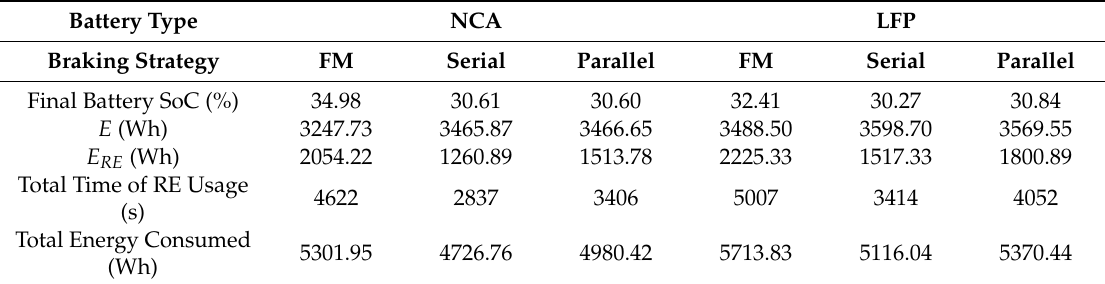
Table 9. Results for the 36.3 kg RE case for the complete